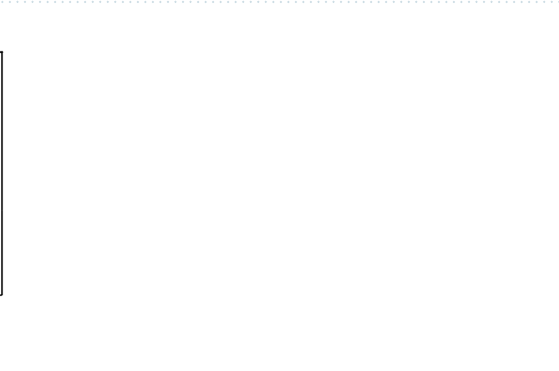
Figure 2. Three different immersion mediums: ( a ) distilled water (pH 7), ( b ) seawater (pH8), and ( c ) an acidic solution (pH 3).